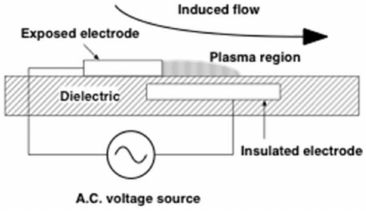
Figure 1. DBD (dielectric barrier discharge) plasma actuator.